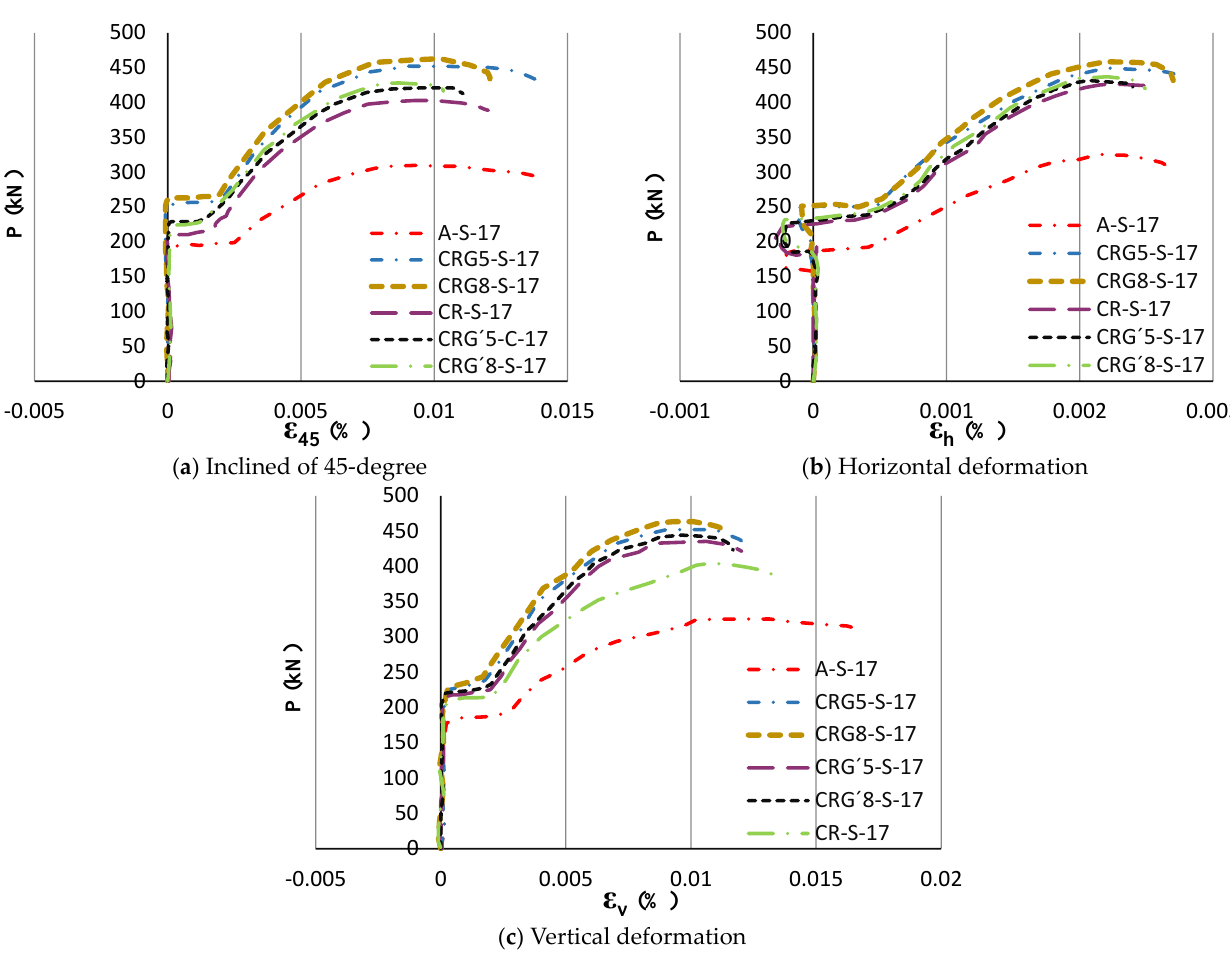
Figure 11. Load-axial deformation curves of the reference and strengthened beams.